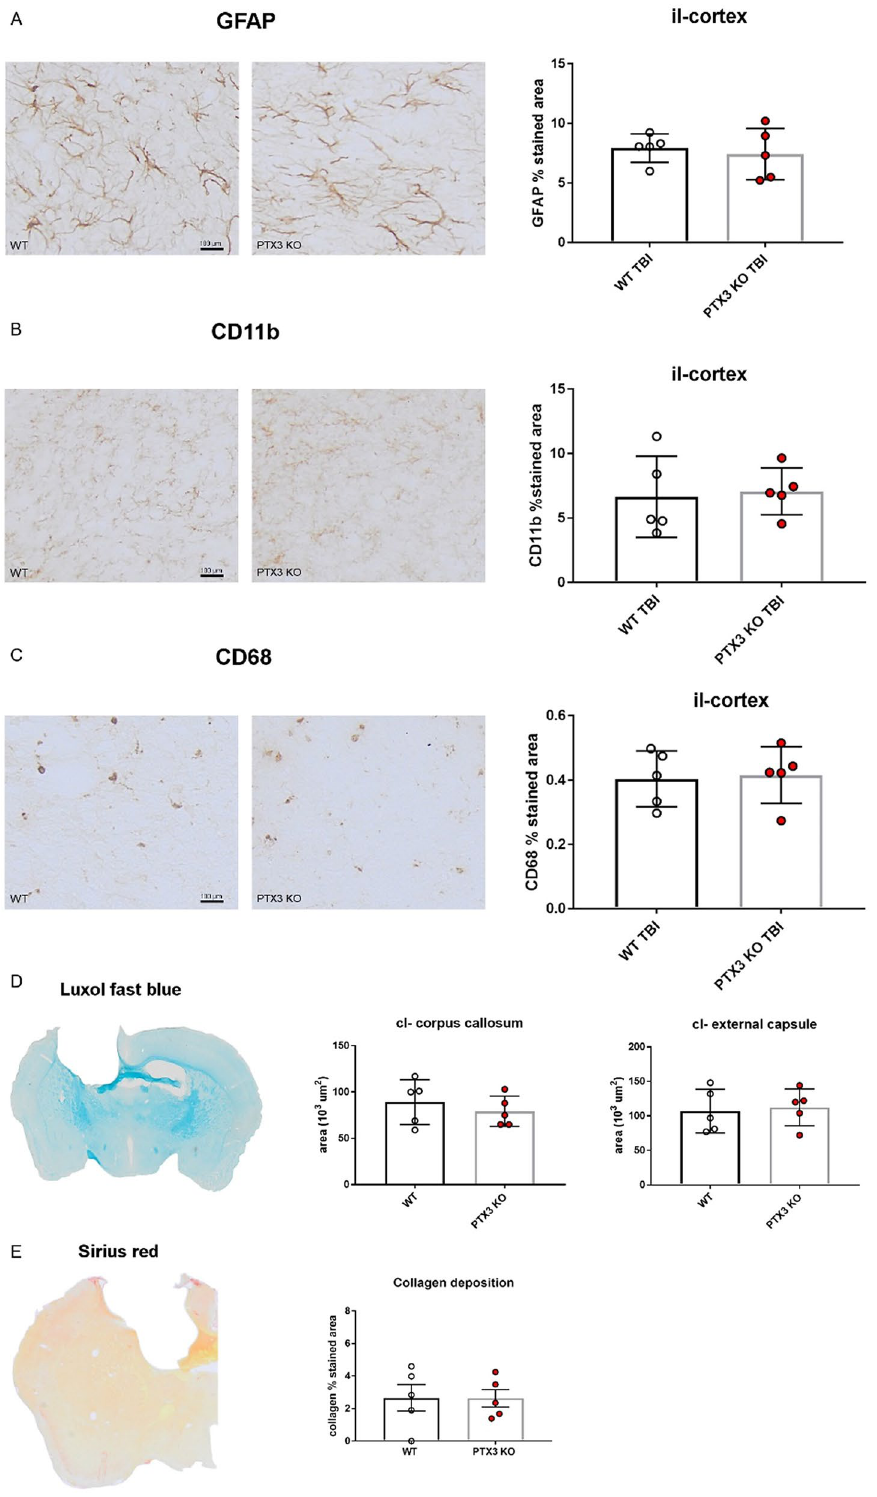
Figure 8. PTX3 depletion did not modify brain inflammatory response at 5 weeks after TBI. Astrocytes ( A , GFAP), brain myeloid cells ( B , CD11b; C , CD68) and collagen deposition ( E , by sirius red) were quantified in the quantified in the ipsilateral (il)-cortex within the first 350 μm from the edge of the contusion showing no difference between WT and PTX3 KO. Axonal loss in contralateral (cl)-corpus callosum and external capsule ( D , by luxol fast blue) did not differ between the two strains. Data is presented as mean ± SEM, n = 5 (TBI WT/ PTX3 KO). Unpaired t-test =